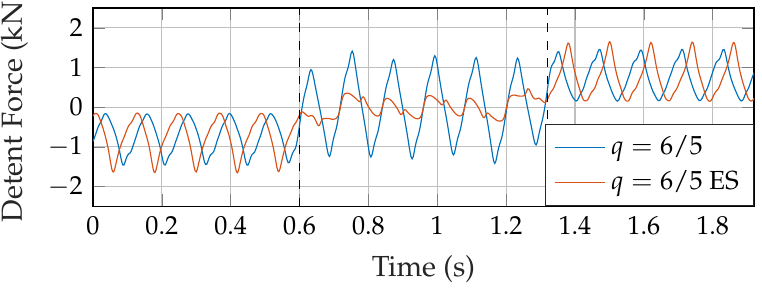
Figure 12. Detent forces for q = 6 5 with extended stator (ES). Full active stator area is from t = 0.6 s to t = 1.32 s, indicated by the dashed vertical lines.